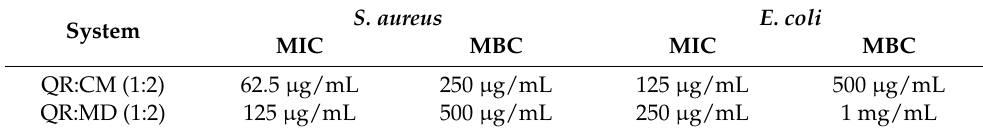
Table 4. MIC and MBC for the best AgNPs systems.